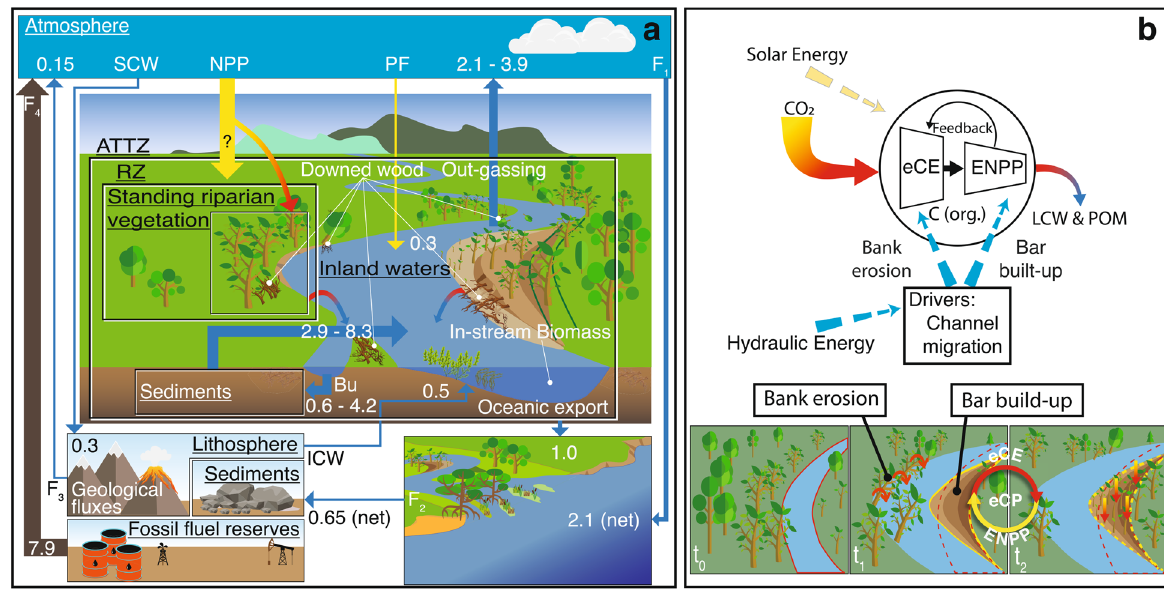
Figure 1. The eco-morphodynamic Carbon Pumping mechanism and global carbon budget of the aquatic- terrestrial transitional zone in rivers, with fluxes reported in PgC/year (global esteems, not only tropical). ( a ) Red-to-blue arrows represent woody vegetation recruited through river morphodynamic activities (eCE), estimated in the present work to 8.9 TgC/year for large tropical rivers (width > 200 m) in the Neotropics (i.e., South and Central America). Yellow-to-red arrows refer to ENPP (see main text). SCW: atmospheric CO